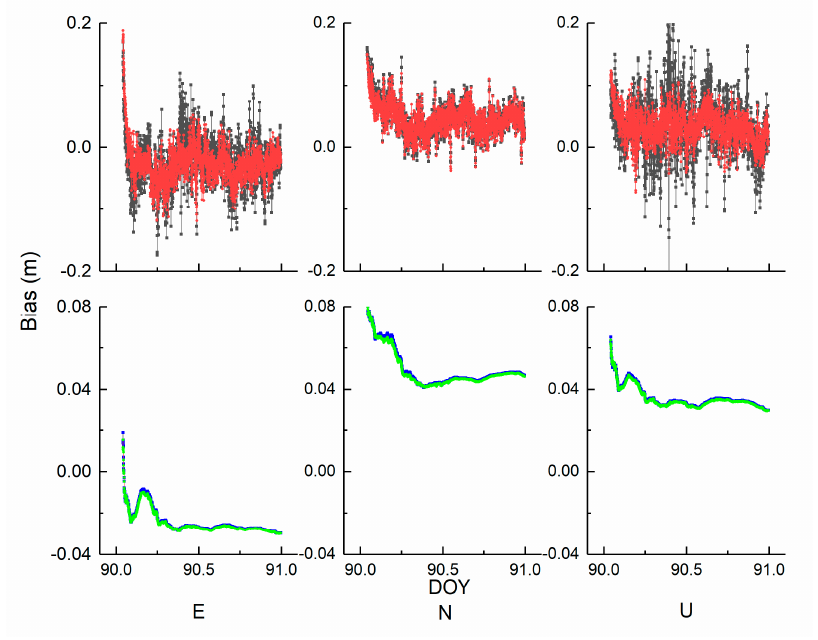
Figure 6. The time series of BRUX East (E), North (N), and Up (U) positioning accuracy.